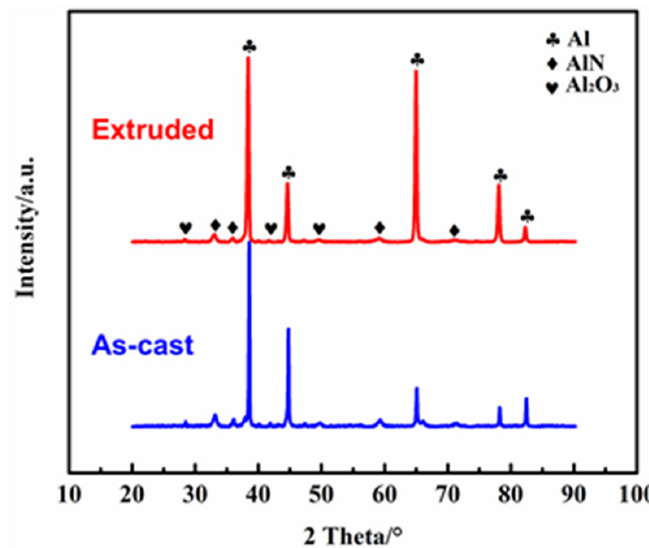
Figure 5. XRD patterns of nano ‐ AlN/AA6061 composite.